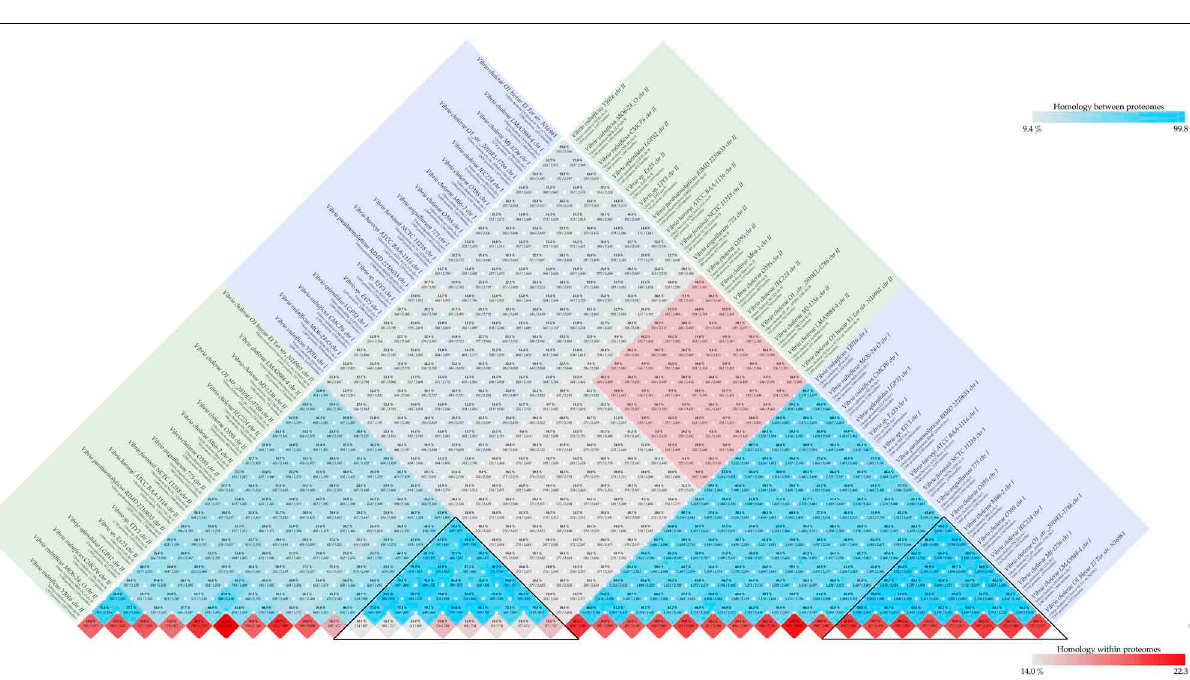
FIGURE 2 | Vibrio chromosome comparison. Comparison was performed for set of 18 genomes. The blue and green square boxes represent chromosomes 1 and 2, respectively. The red-colored box in the middle of the